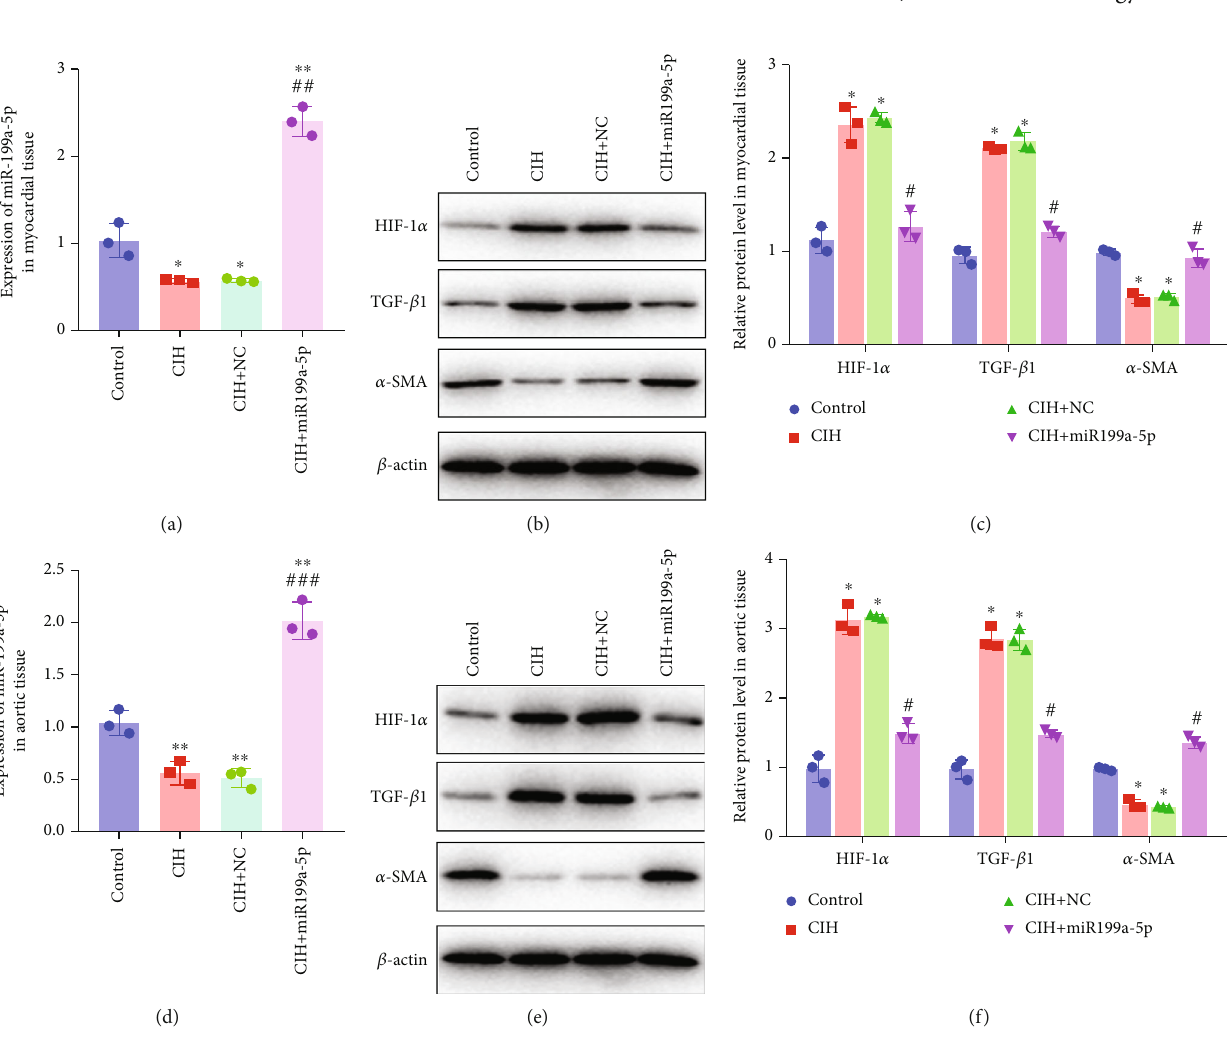
Figure 4: Overexpressed miR-199a-5p attenuated vascular remodeling. (a) mRNA expression of miR-199a-5p in myocardial tissue by qRT- PCR. (b) Protein expression of HIF-1 α , TGF β 1, and α -SMA in myocardial tissue by western blot and (c) quanti fi cation. (d) mRNA expression of miR-199a-5p in aortic tissue by qRT-PCR. (e) Protein expression of HIF-1 α , TGF β 1, and α -SMA in aortic tissue by western blot and (f) quanti fi cation. CIH: chronic intermittent hypoxia; NC: negative control. ∗ P < 0 : 05 , ∗∗ P < 0 : 01 compared with control; # P < 0 : 05 , ## P < 0 : 01 , and ### P < 0 : 001 compared with